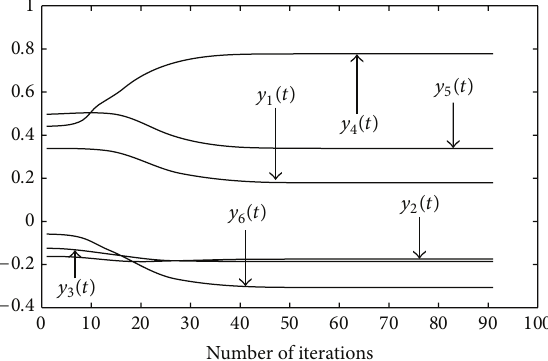
Figure 6: Trajectories of 𝑦(𝑡) = (𝐴 − 𝐴 𝑇 )𝑥(𝑡)/2𝑏 3 based on (10) with initial 𝑥(0) as (55), which should converge to the real part of an eigenvector of 𝐴 corresponding to the eigenvalue 𝜆 3